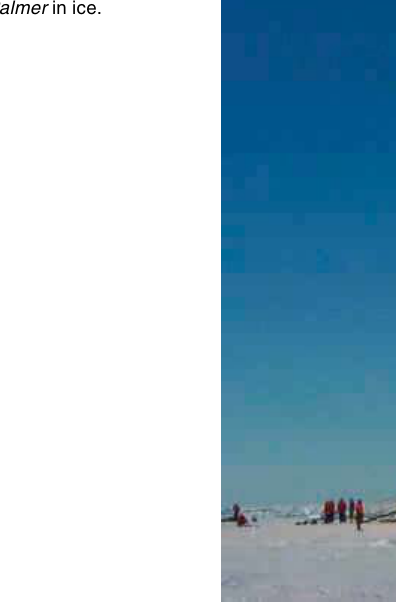
Figure 1. The Nathaniel B. Palmer in